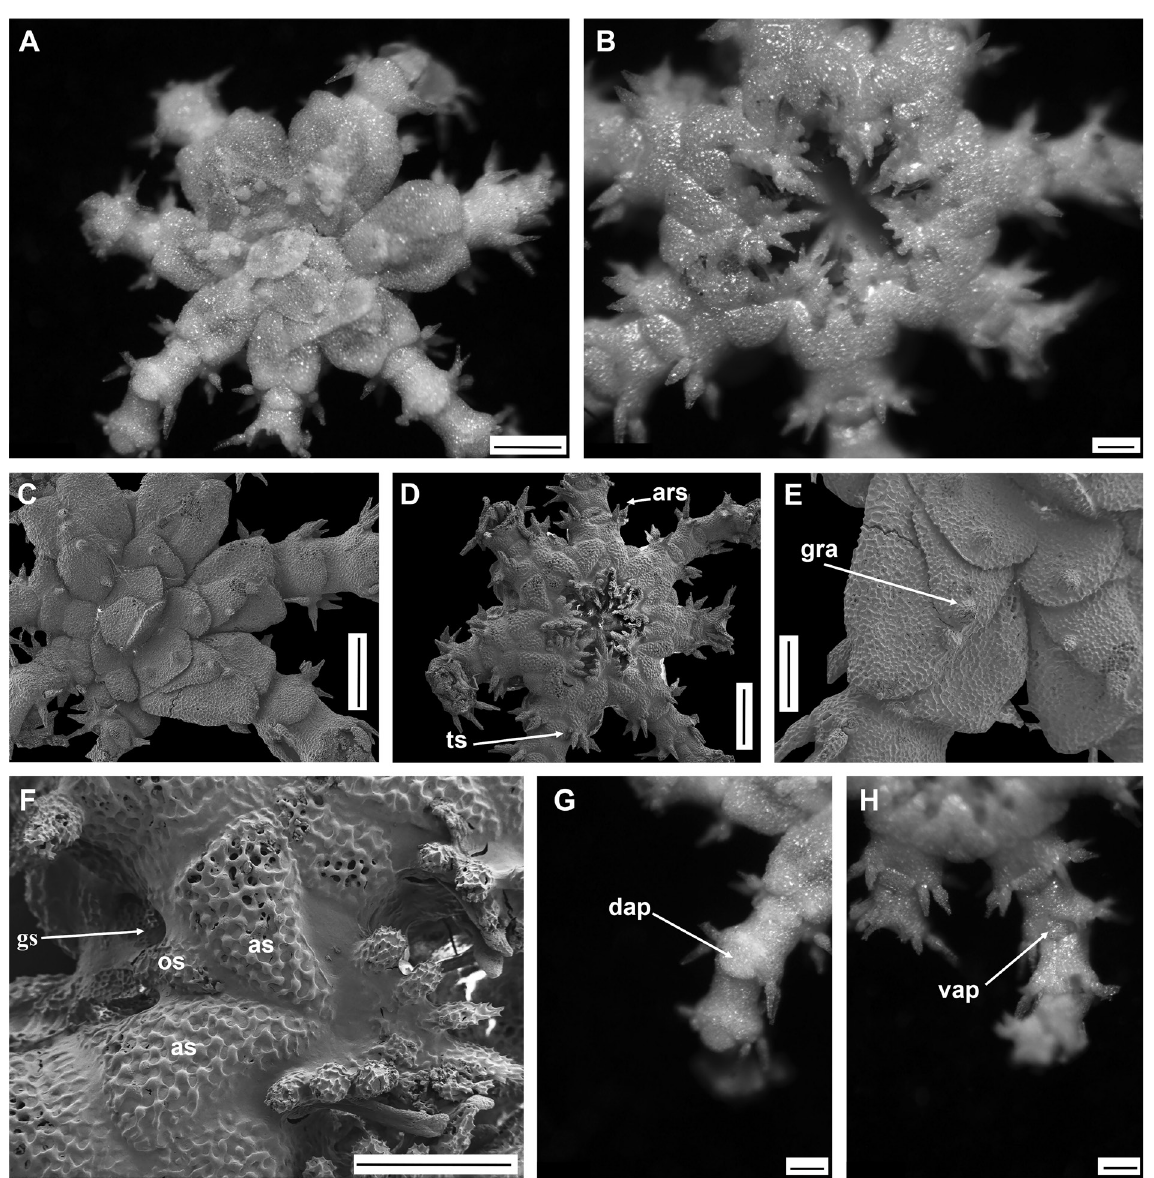
Fig. 34. Ophiomoeris petalis sp. nov., holotype (IDSSE EEB-SW0029). A . Dorsal disc. B . Ventral disc. C . Dorsal disc (SEM). D . Ventral disc (SEM). E . Dorsal disc lobe (SEM). F . Oral frame (SEM). G . Dorsal arm. H . Ventral arm. Abbreviations: ars = arm spine; as = adoral shield; dap = dorsal arm plate; gra = granula; gs = genital slit; os = oral shield; ts = tentacle scale; vap = ventral arm plate. Scale bars: A, C = 500 µm; B, G–H = 200 µm; D = 1 mm; E = 250 µm; F = 300